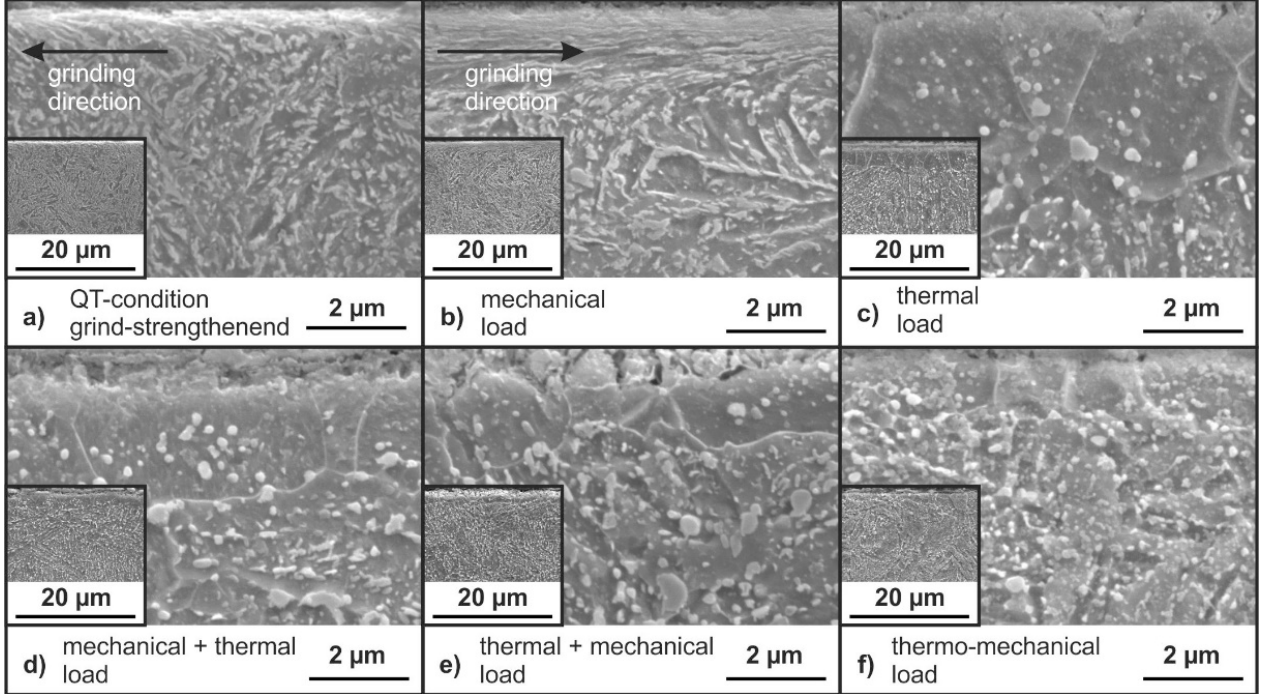
Figure 12. SEM-micrographs of the QT-condition with small cutouts in lower magnification for an impression of the microstructure ( a ) as ground and after the application of ( b ) a mechanical load (σ maxQT ) ( c) a sequence of an initial mechanical load (σ maxQT ) followed by a thermal load (1 h at 700 °C) ( d ) a thermal load (1 h at 700 °C) ( e ) a sequence of an initial thermal load (1 h at 700 °C) followed by a mechanical load (σ maxQT ) ( f ) a simultaneous combination of the mechanical (σ maxQT ) and the thermal load (1 h at 700 °C).